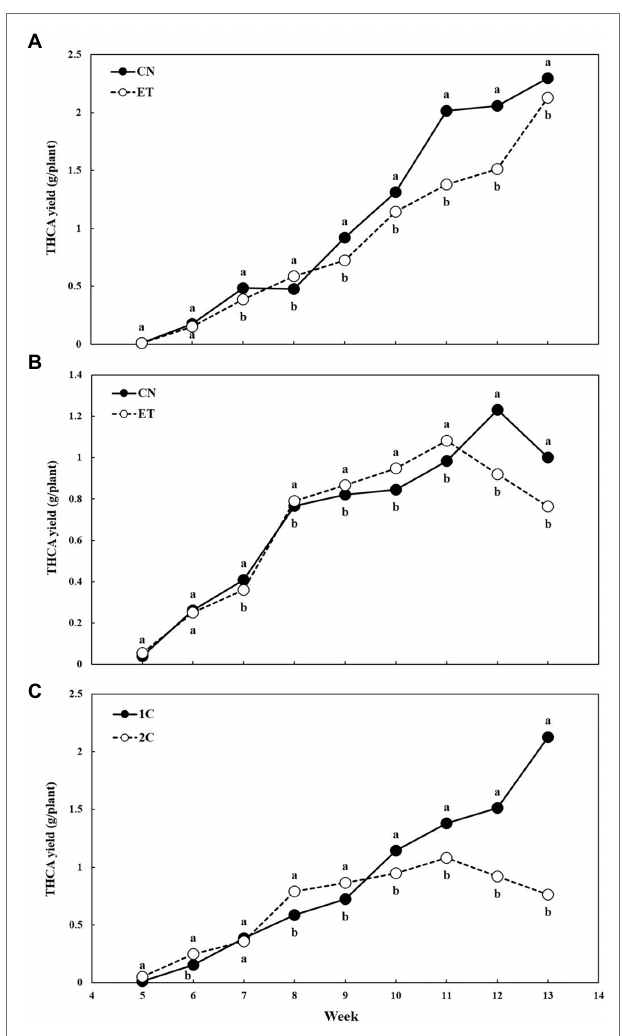
FIGURE 8 | Tetrahydrocannabinolic acid (THCA) yield per plant as affected by amino acid (AA) supplementation and nutrient cycle. THCA yield per plant in control (CN) and enhanced treatment (ET) with AAs nutritional supplements in recirculation (1C) nutrient cycle (A) , in drain-to-waste (2C) nutrient cycle (B) , ETs in 1C and 2C (C) . The whole inflorescence of the plant was analyzed. Data are means ± SE ( n = 3). Different bold small letters represent significant differences in cannabinoid concentration between the variants in a particular week according to Tukey’s HSD test at α =